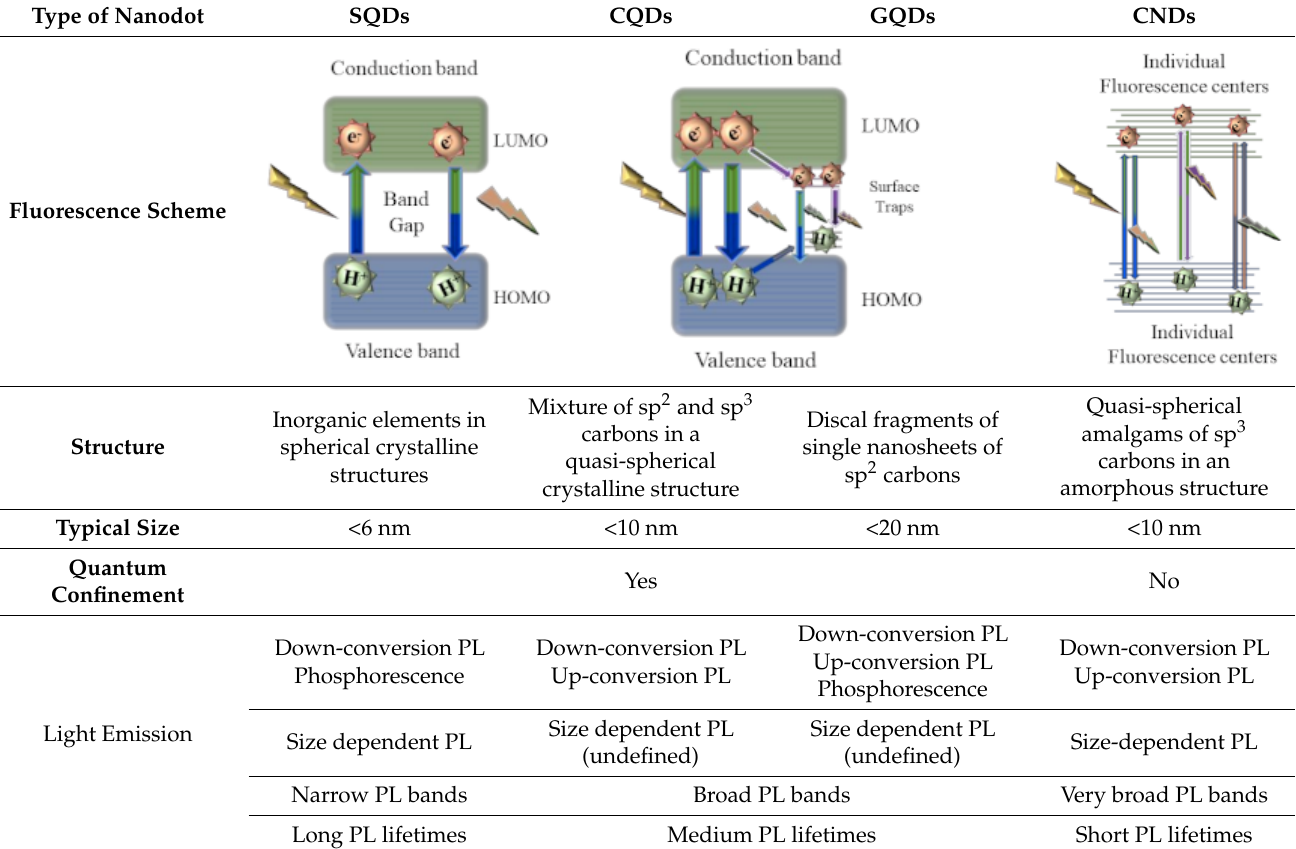
Table 1. Comparison of the different photoluminescence mechanisms and particular features of semiconductor quantum dots (SQDs) and carbon-based